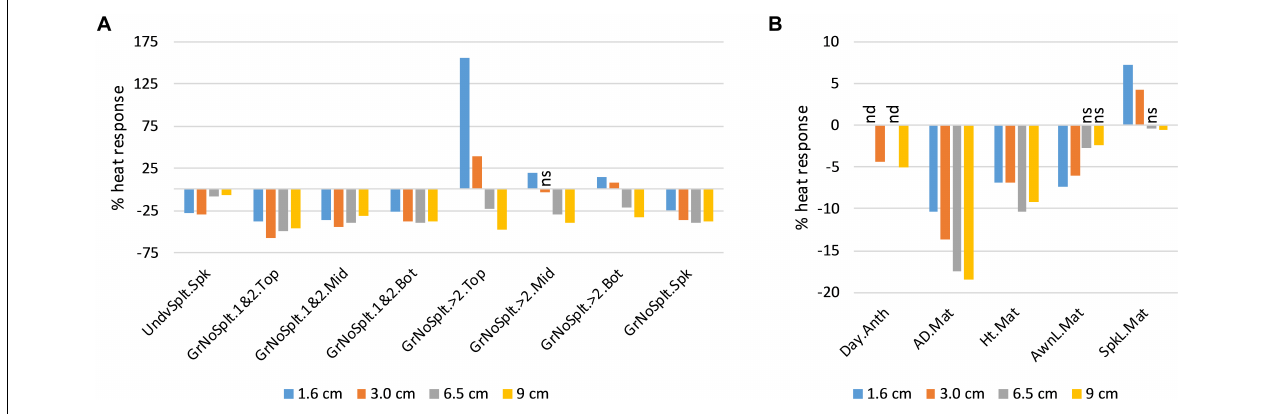
FIGURE 1 | Average trait heat responses (%) of Drysdale × Waagan DH lines, relative to controls. All responses were significant at p < 0.01 unless indicated. nd, not determined; ns, not significant. (A) Fertility-related traits. (B) Growth and development traits. See Table 1 for trait key. TABLE 2 | Loci for heat responses of floret fertility identified in the DH QTL experiment. Locus Linkage group Position (cM) Peak markers Tolerance allele a LOD R 2 Additive